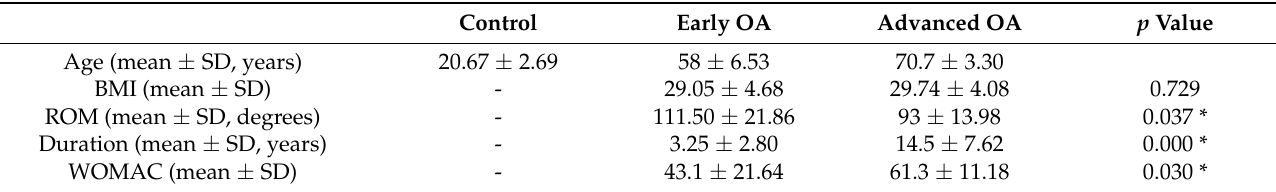
Figure 1. Hystological staining of healthy (ctrl) ( A ), early osteoarthritic synovium (eOA) ( B ), and advanced osteoarthritic synovium (aOA) ( C ). The synovial membrane of patients in the control group shows no resident cells in the subintima and the intima (arrows). In patients with early OA, the synovium contains highly visible cell infiltration (frame) in the intima (arrow). In patients with advanced OA, lymphoid nodules (frame) are shown. Haematoxylin-eosin staining. Magnification × 20, scale bar 50 µ m. Table 1. Clinical characteristics of the examined